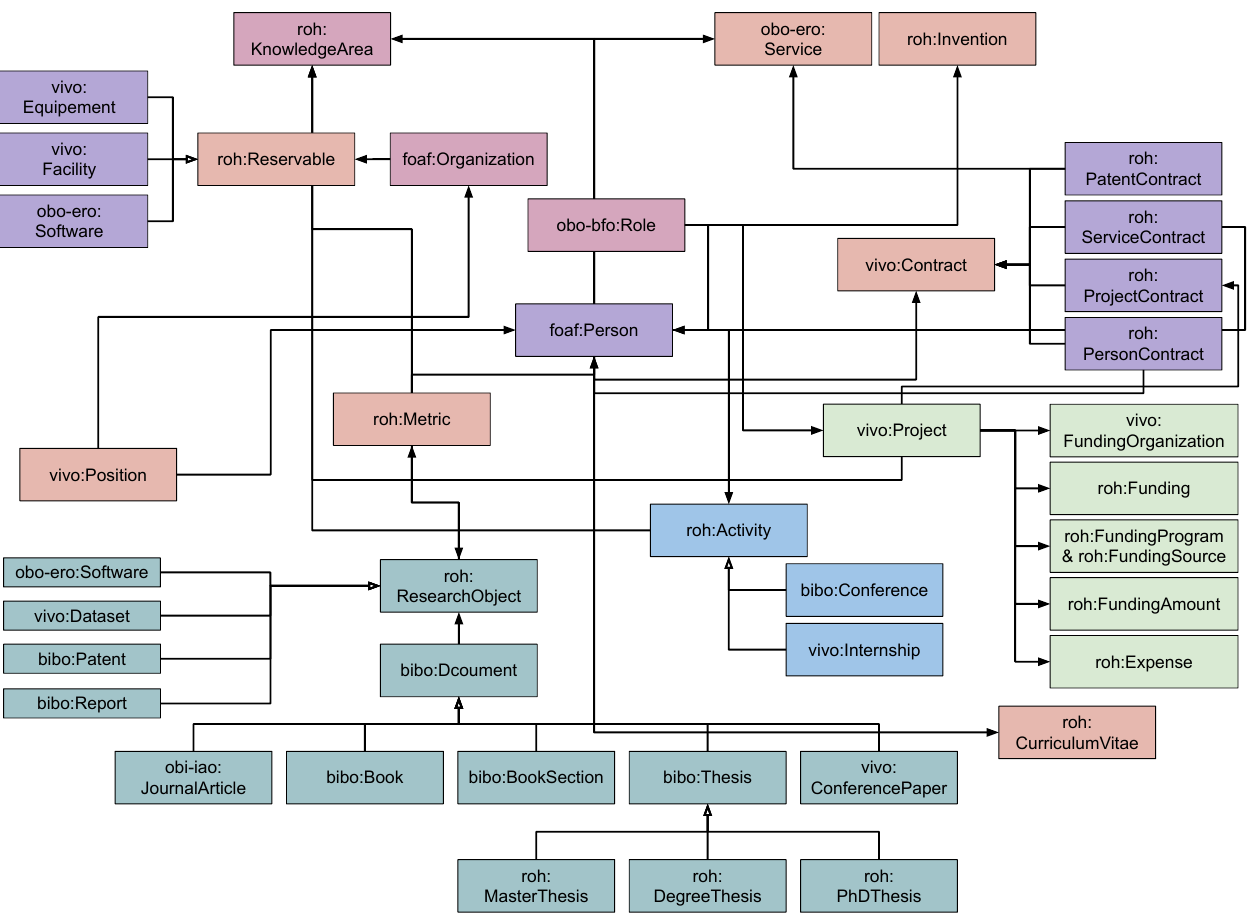
Figure 1. Overview of the ROH ontology with its main classes [11], adapted from the official ontology documentation. Arrows with a filled tip denote an inheritance relationship, while arrows with a nonfilled tip indicate an object property relationship. Dashed arrows denote temporal and geographical constraints. Each color represents classes that pertain to the same entity. Although this is not a standard notation for ontology diagrams, we have to use this diagram, as was the way the documentation was